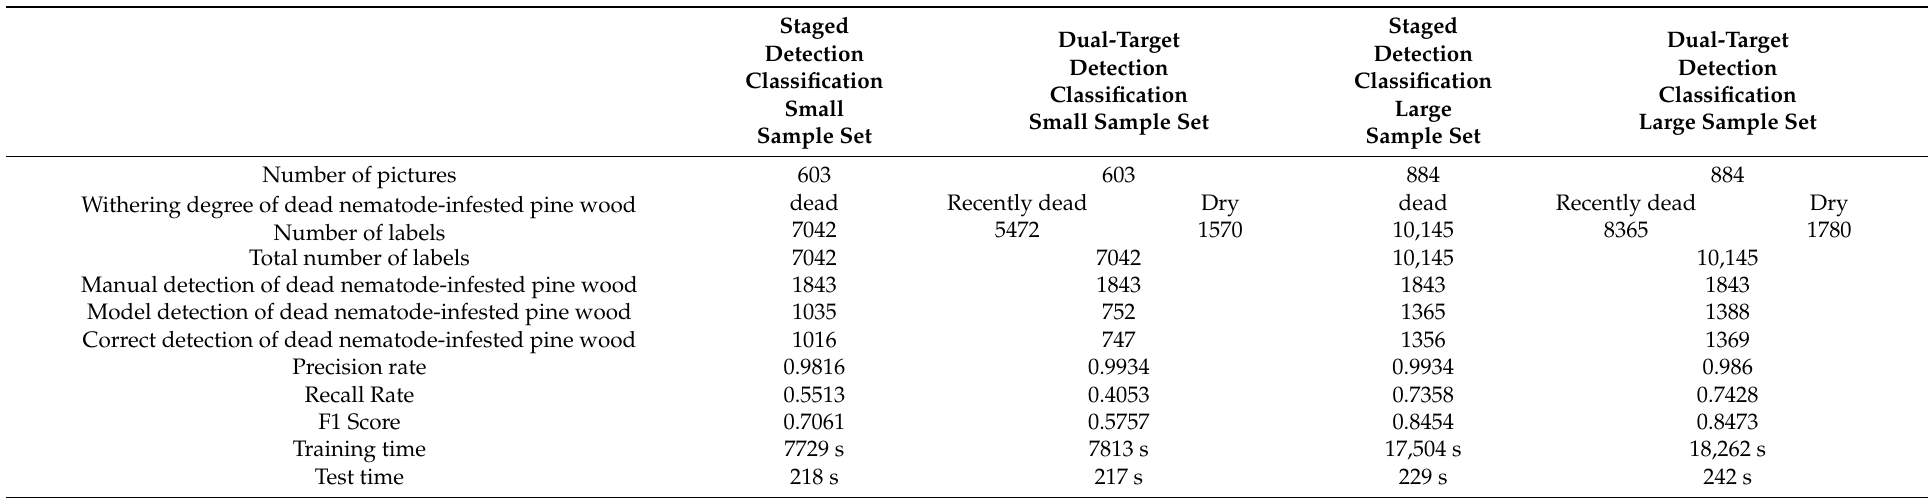
Table 7. Comparison of detection effect between staged detection classification and dual-target detection classification.